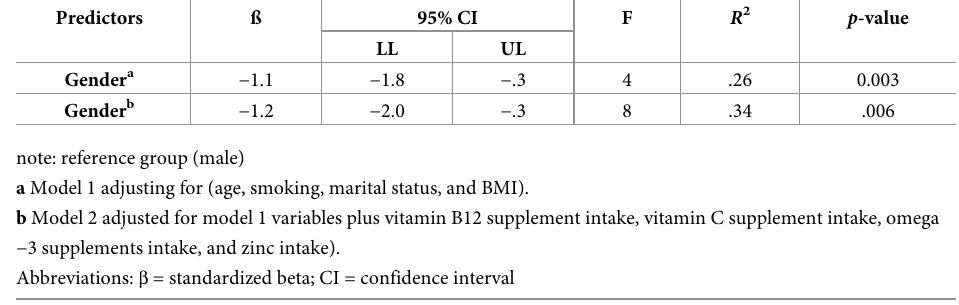
Table 5. Multiple linear regression analysis to assess the association of total pa with gender as an independent